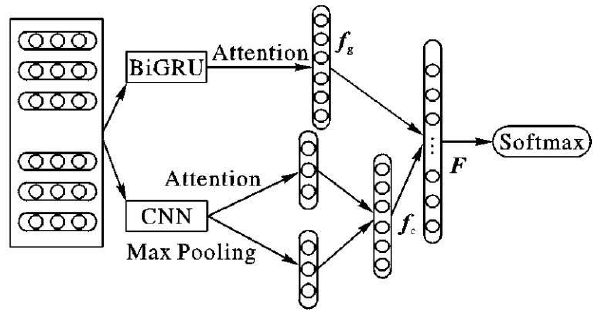
Figure 1. Structure of proposed